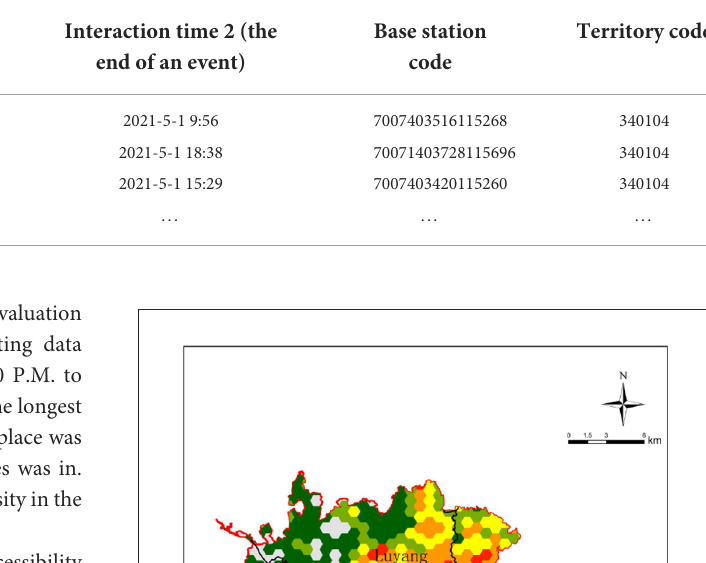
TABLE 3 Sample data of interaction information collected by mobile phone signaling base station.